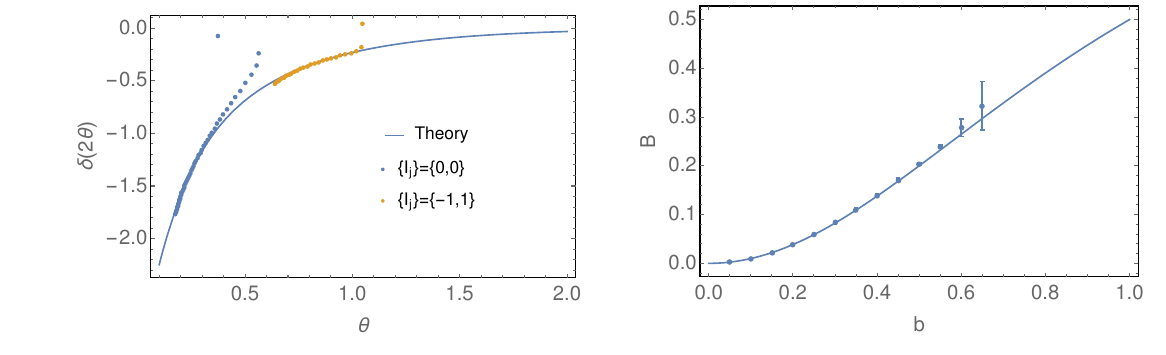
(a) Measured versus theoretical phase shifts (b) Measurement of the parameter B of the obtained from the n = 0 and n = 1 two-particle S -matrix as a function of b . states at b = 0 . 4 . Figure 12. Measurement of the